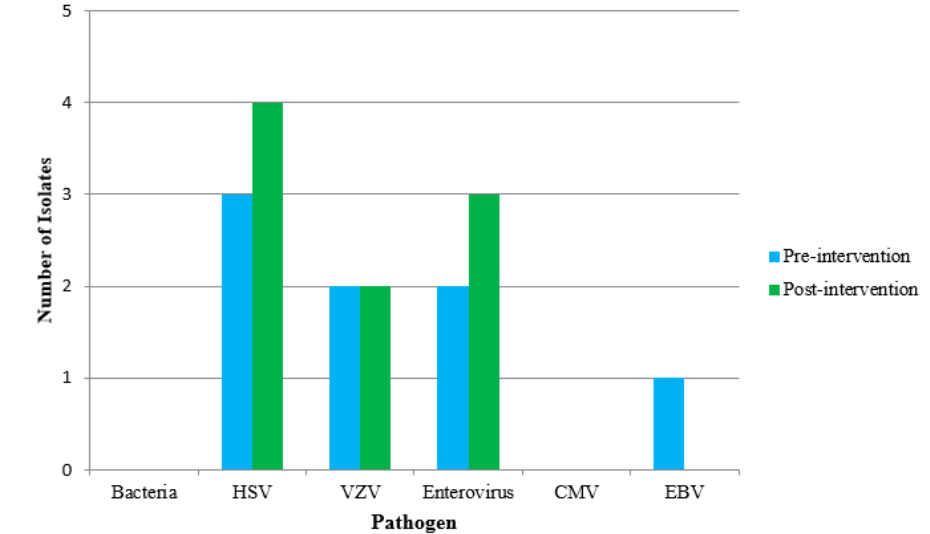
Figure 1. Patient Screening. * Multiple exclusion criteria could be applied to each patient. Abbreviations: LP: Lumbar puncture, OSH: Outside hospital, CNS: Central nervous system, PCR: Polymerase chain reaction.